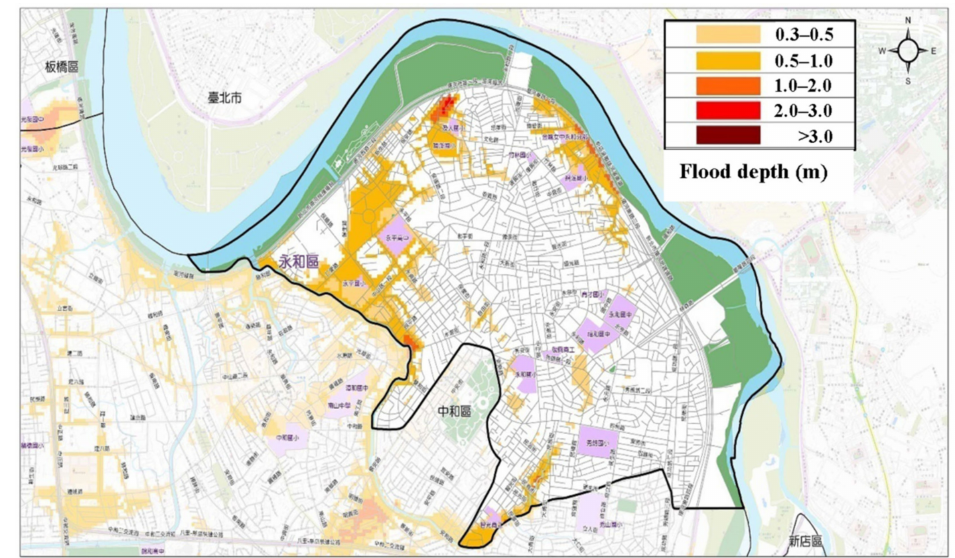
Figure 18. Flooding map based on 350 mm of rainfall for a duration of 6 h in Yonghe